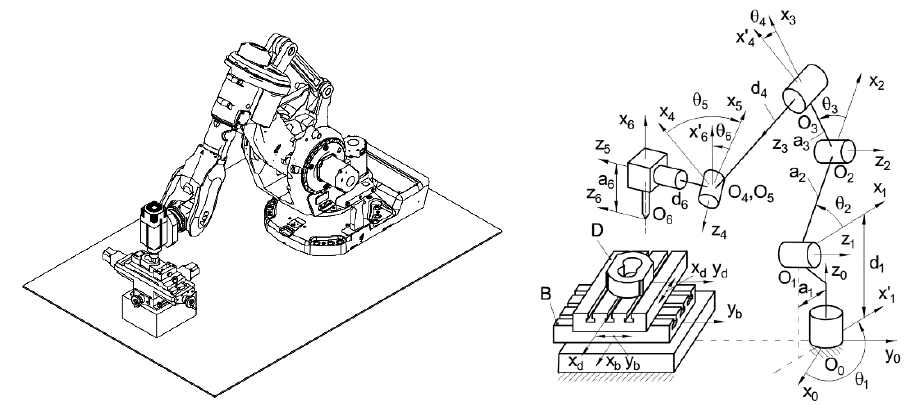
Figure 1. The model of robot; clamping platform has eight degrees of freedom (DOF) in milling process.